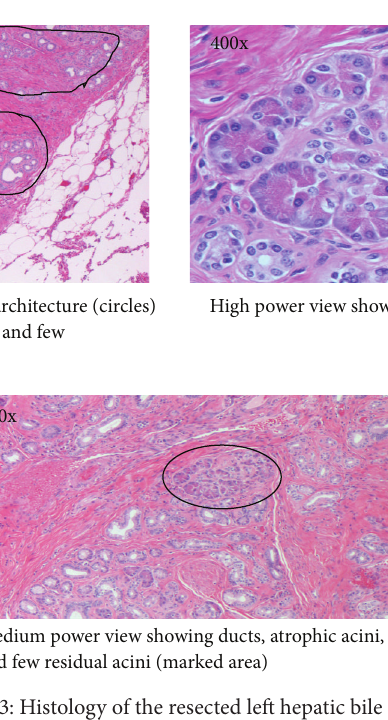
Figure 3: Histology of the resected left hepatic bile